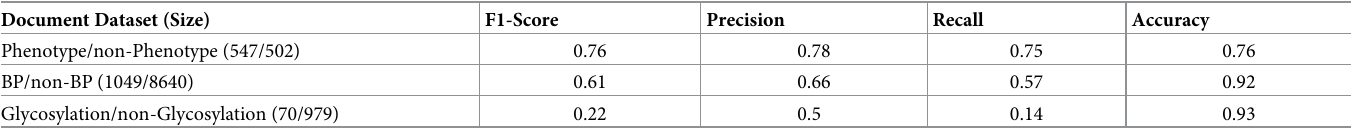
Table 1. Logistic regression utilizing binary representation of